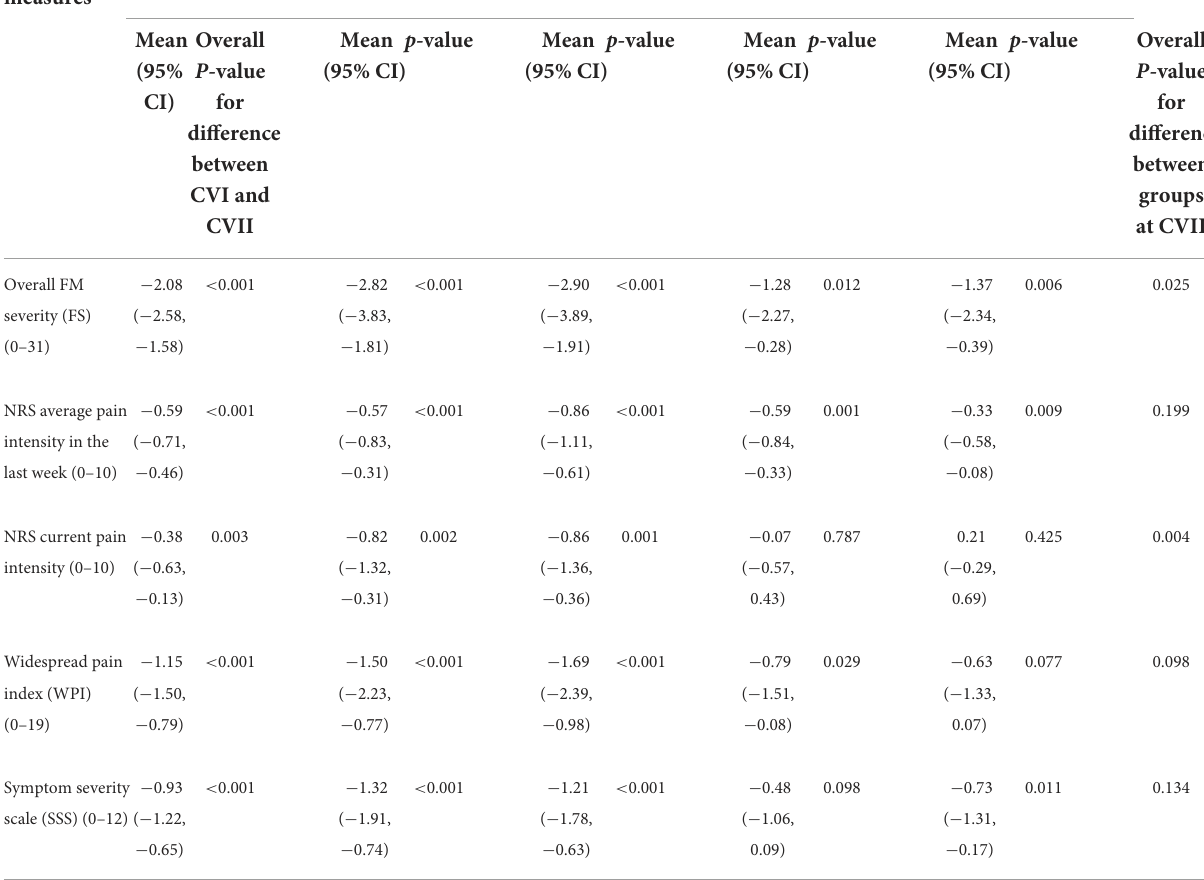
TABLE 4 Mean (95% CI) differences between treatment groups at 2 wk follow-up and total average change from baseline to follow-up for secondary outcomes (Imputed analyses adjusted for baseline differences; N =